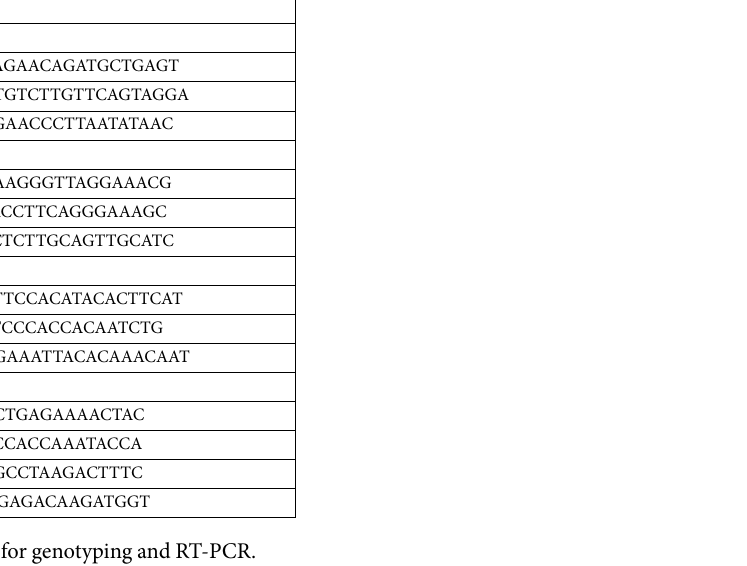
Table 1. Primers used for genotyping and